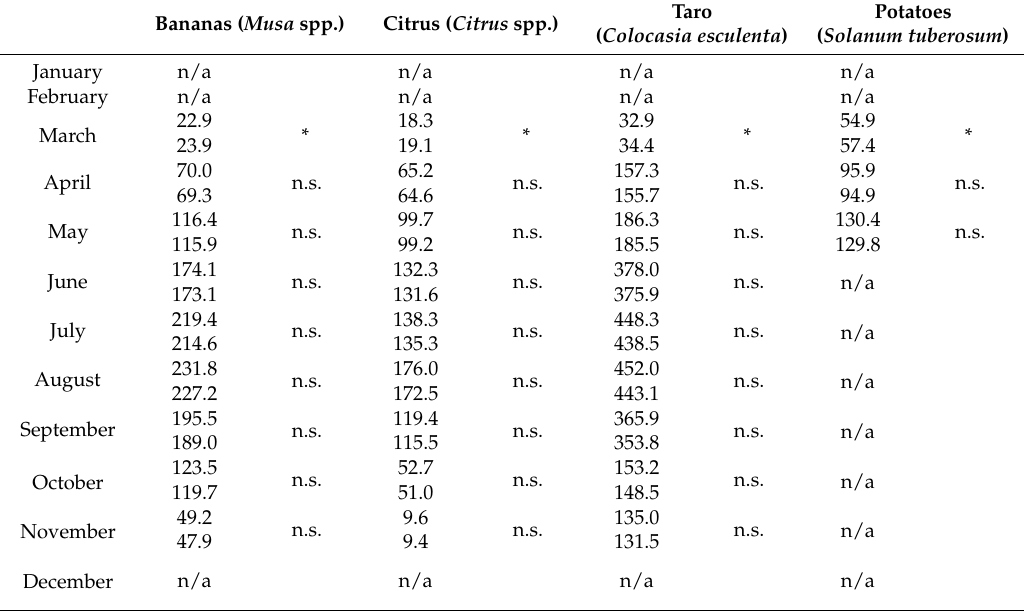
Table 2. Crop evapotranspiration (ETc) values in mm of the most water-consuming crops in Cyprus. The upper number for each month indicates the average value for the 1976–2000 period and the lower number indicates the average value for the period 1990–2014. Non-significant differences between these two averages are indicated by n.s. (paired t -test) and significant differences ( p < 0.05) by *. Months that are not included in the irrigation period of a crop are indicated by n/a (non-applicable). Taro Potatoes Bananas ( Musa spp.) Citrus ( Citrus spp.) ( Colocasia esculenta ) ( Solanum tuberosum